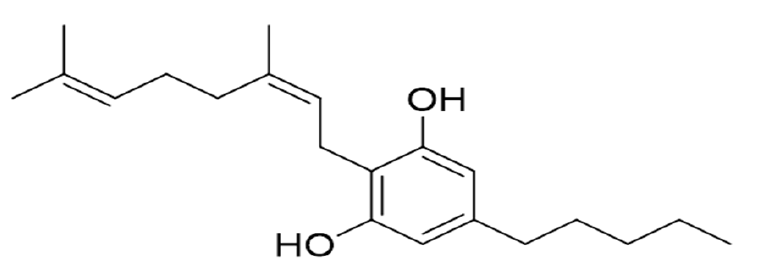
Figure 1. Chemical structure of cannabinerol (CBNR).